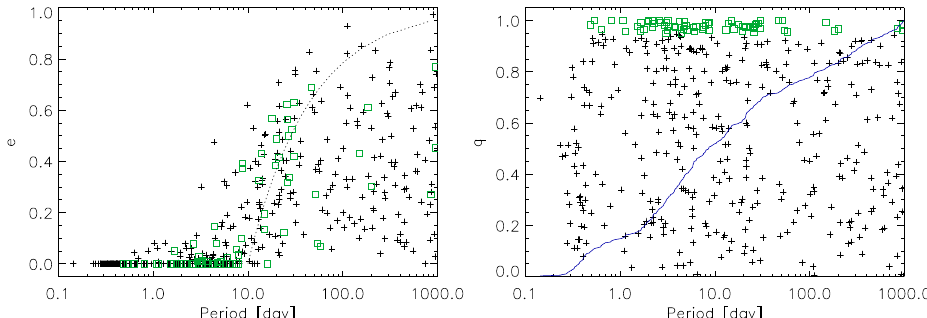
Figure 4. Properties of the inner subsystems in hierarchies. The left panel shows eccentricity e vs. period, the right panel plots the inner mass ratio vs. period. Green squares distinguish twins with mass ratios q > 0.95. The dotted line in the left panel corresponds to separation at periastron equal to the radius of a circular 10-day orbit. The blue line in the right panel is the cumulative period